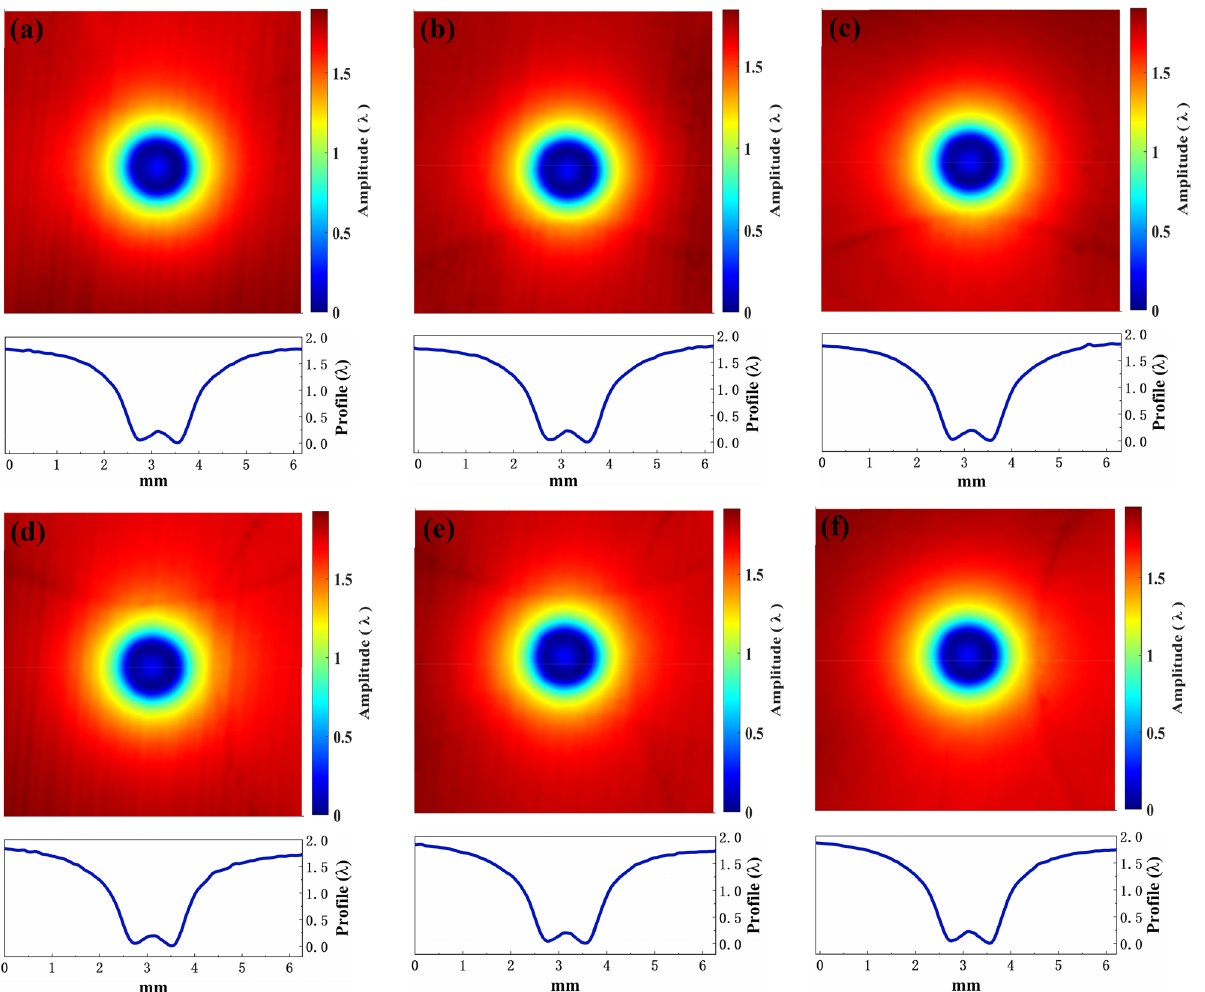
Figure 7. The 3D removal characteristics and corresponded 2D morphology features of jet spots using the BT1 (the time, pressure and nozzle are 5 min, 0.5 MPa and 1 mm, respectively. λ = 632 nm).